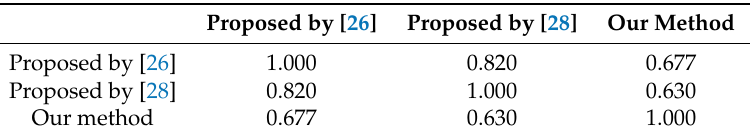
Table 8. Correlation matrix.